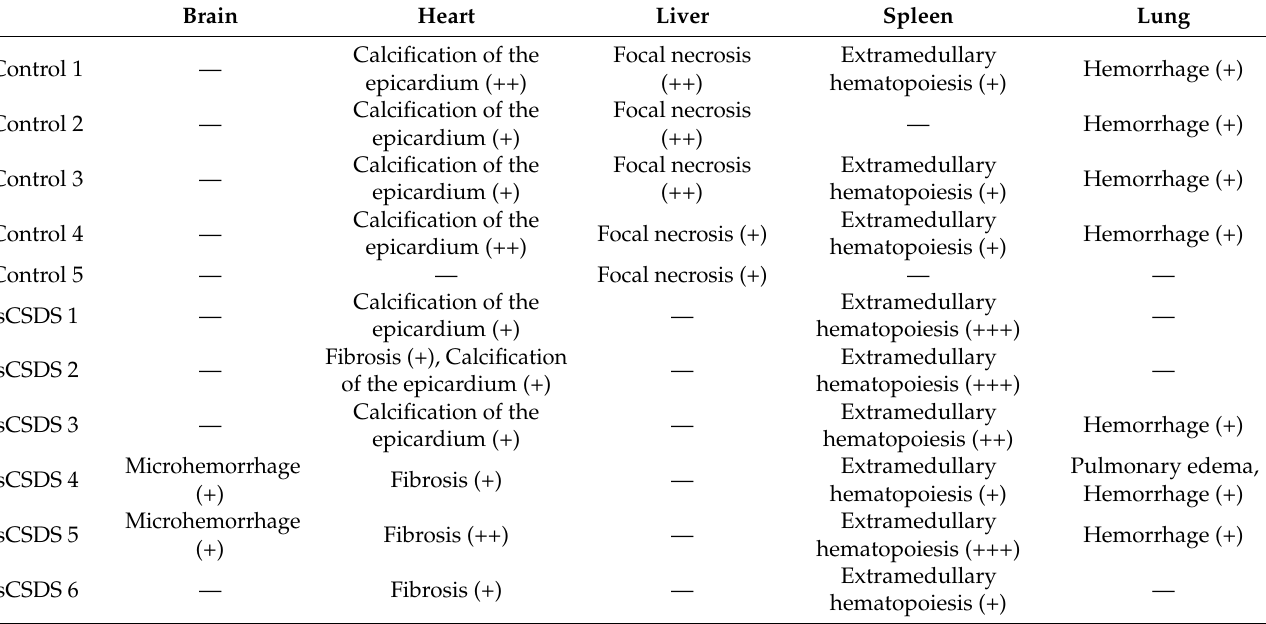
Table 2. Summary of the pathological findings of the tissues in sCSDS and control